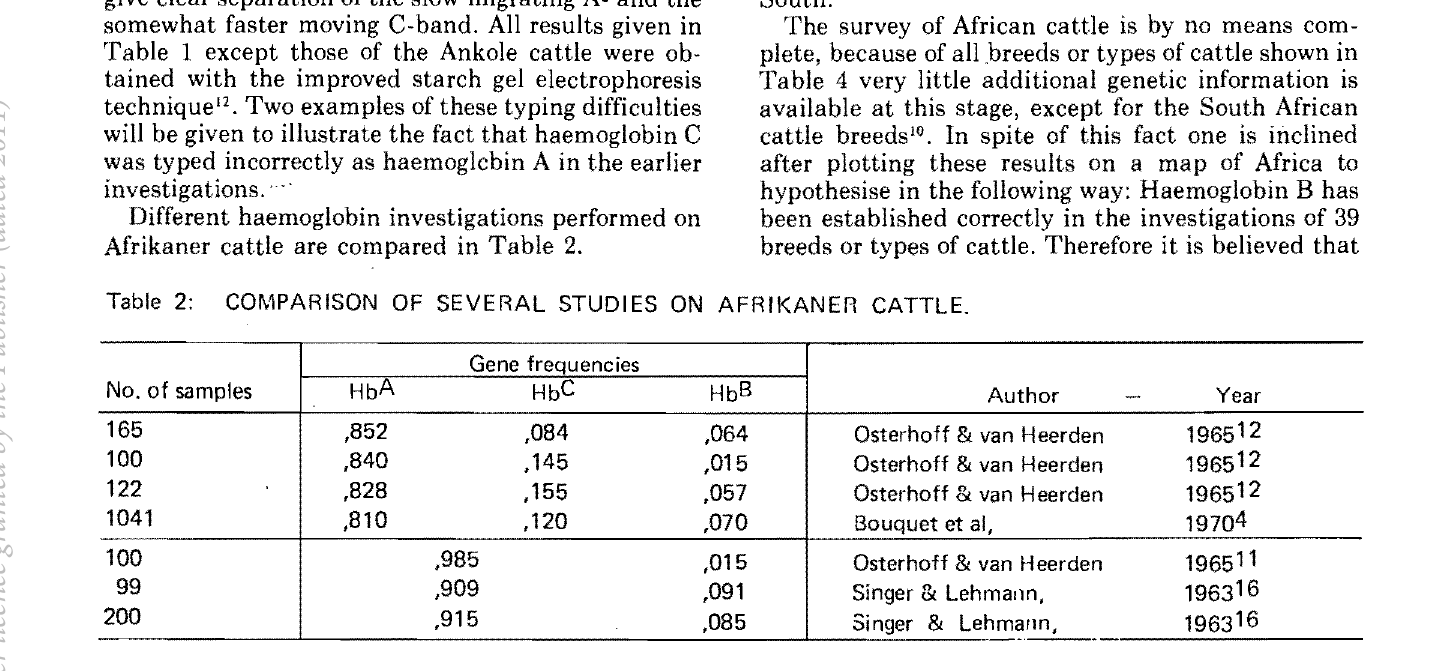
COMPARISON OF TWO STUDIES